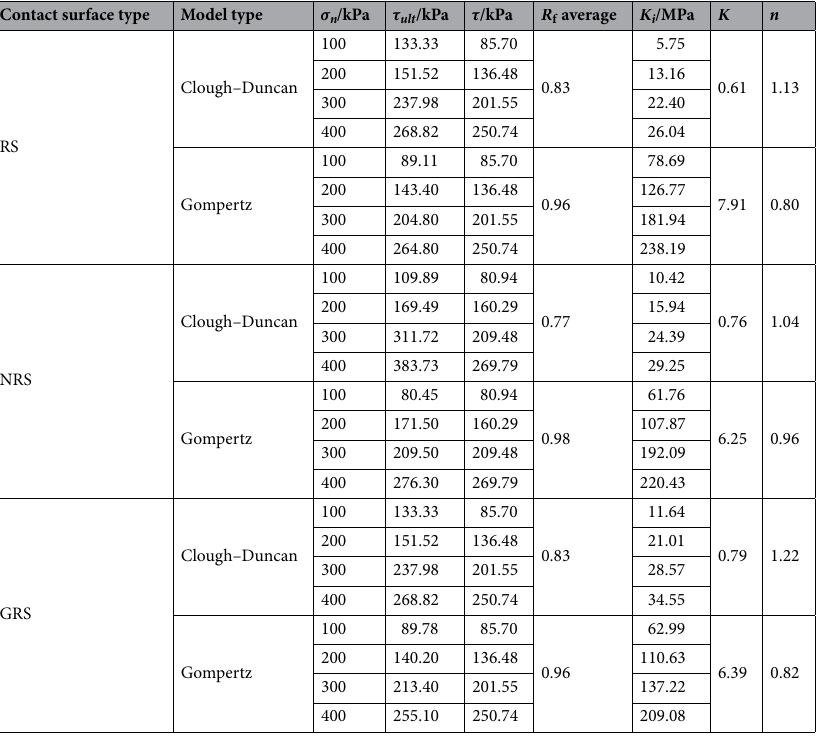
Table 3. Clough–Duncan model and improved Gompertz model fitting